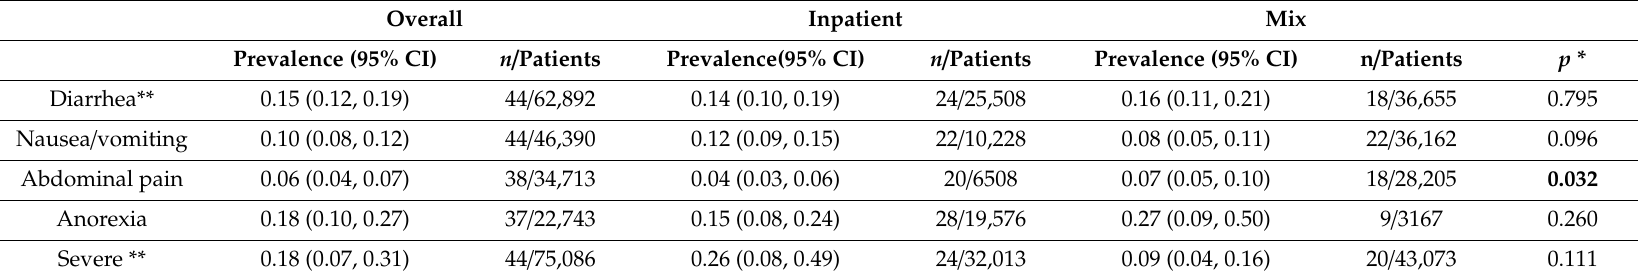
Table 3. Summary of the pooled prevalence estimates of gastrointestinal symptoms with respect to the inpatient / outpatient